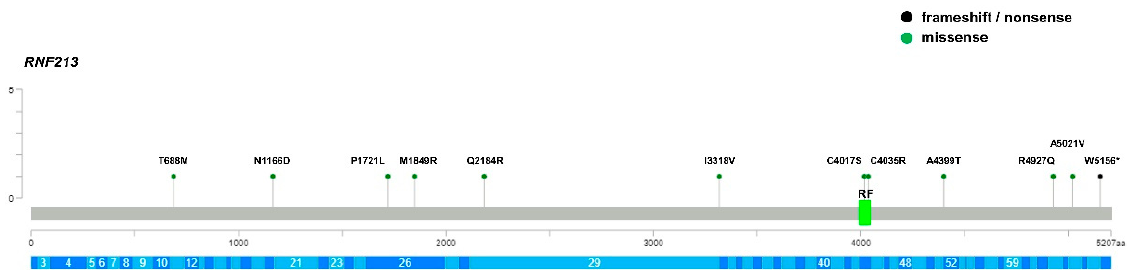
Figure 3. Lolliplot showing distribution and frequency of RNF213 variants identified in MMD patients. RF: RING finger domain; aa: number of protein amino acids; * stop codon. The gene exons are schematized in dark and light blue.